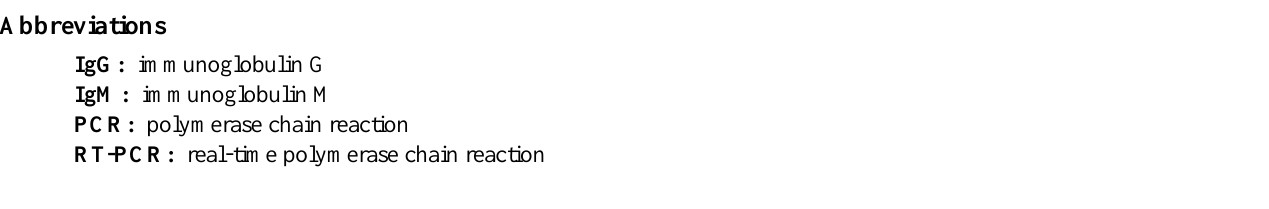
PCR: polymerase chain reaction RT-PCR: real-time polymerase chain